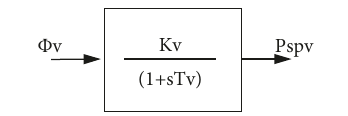
Figure 2: Modeling of SPV